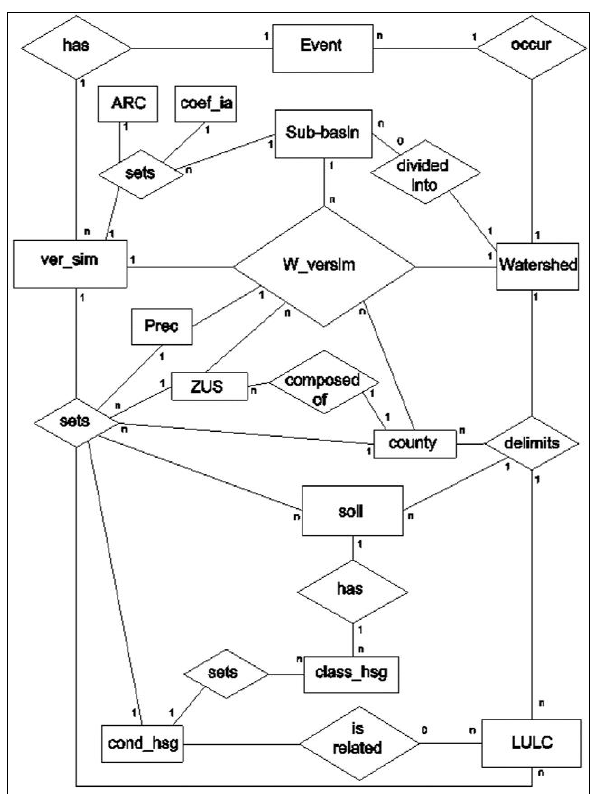
Figure 4: The diagram of verification of changes in watershed characteristics and simulation of direct